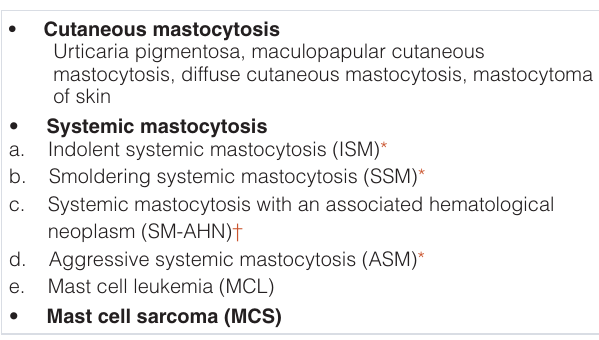
Table 1. The 2016 revision of the World Health Organization classification of mastocytosis 3